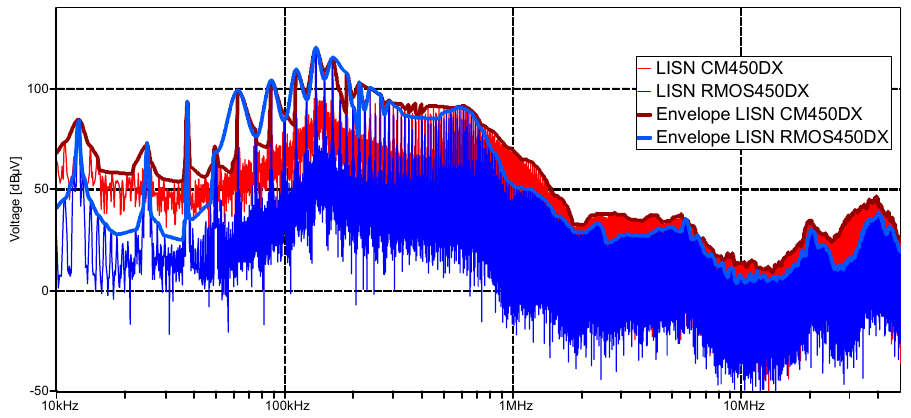
Figure 26. Modeling comparison for CM450DX and RMOS450DX models showing spectra of the LISN.